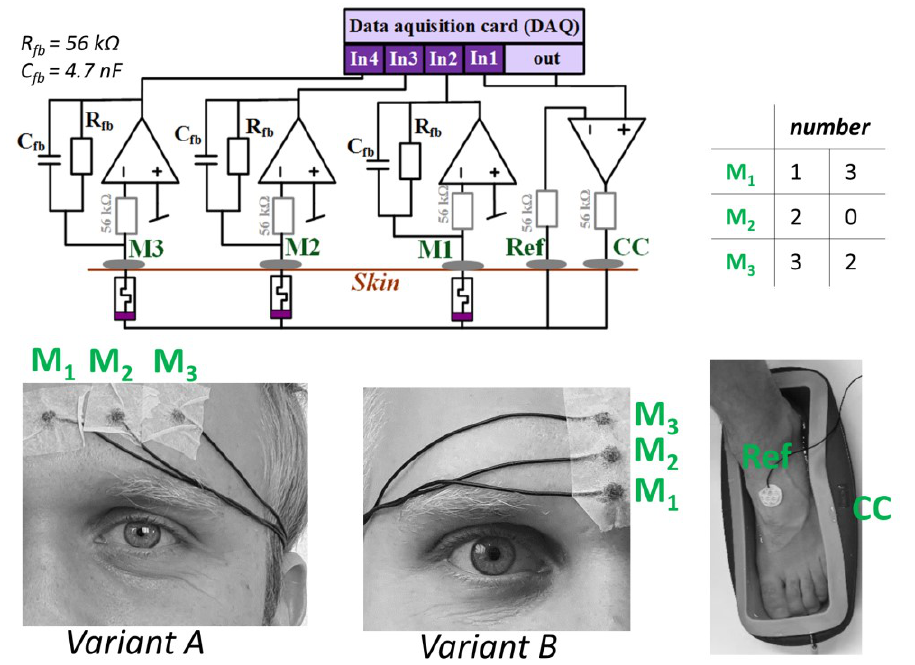
Fig. 1: Schematic of the used instrumentation (same schematic as presented in [9] under Creative Commons Attribution 4.0 International License), electrode placement and the two chosen numbers and the corresponding states (0,1,2,3) under each electrode. The used three electrode setup [13] with CC as the current carrying electrode and Ref as the reference electrode enables monopolar recordings under the measurement electrodes M 1 , M 2 , and M 3 . For the first 6 out of 17 subjects, the three measurement electrodes were placed horizontally along the forehead as shown in variant A. For the remaining 11 out of 17 subjects, the measurement electrodes were placed vertically along the forehead above the nose as shown in variant